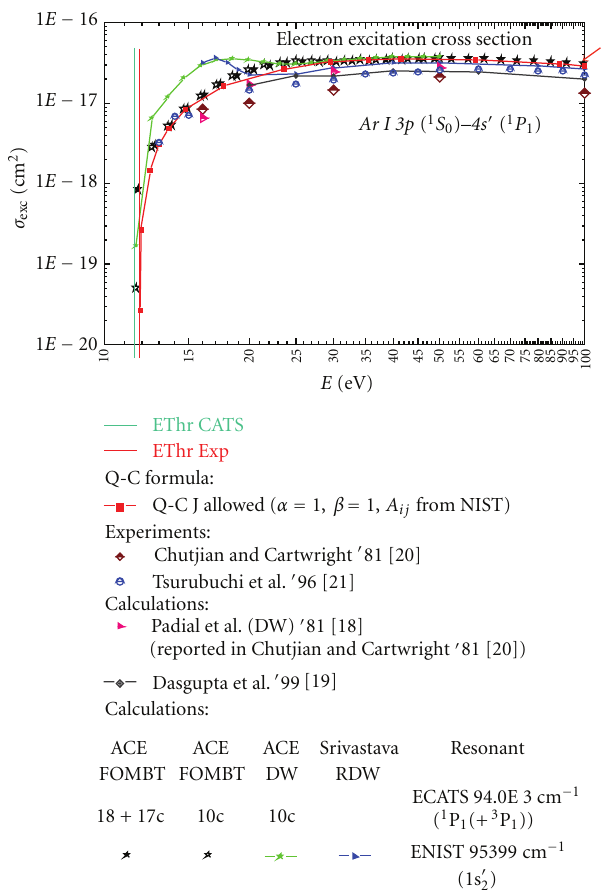
Figure 3: Electron excitation cross section of Ar I 3 p ( 1 S 0 )–4 s (cid:2) ( 1 P 1 ).